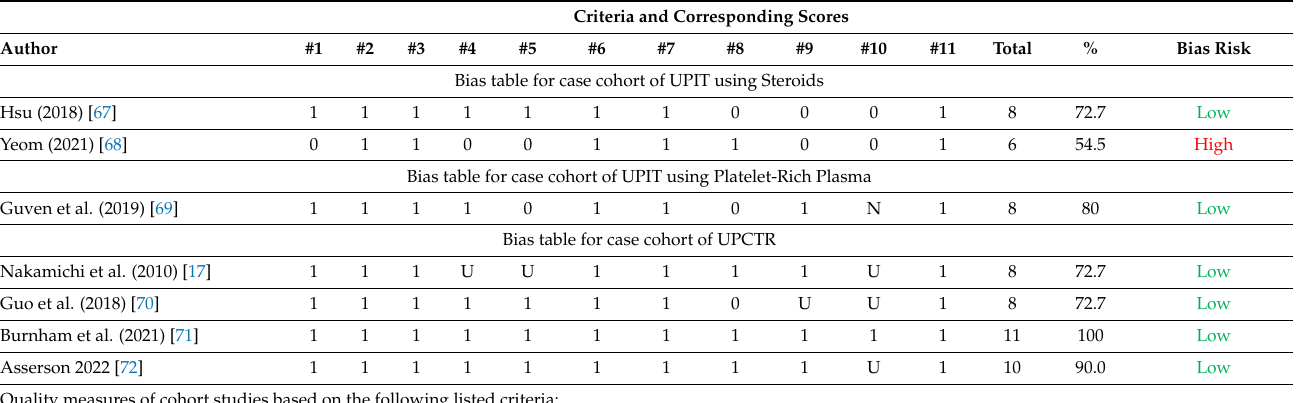
Table 2. JBI Critical Appraisal Checklist for Cohort Studies. Criteria and Corresponding